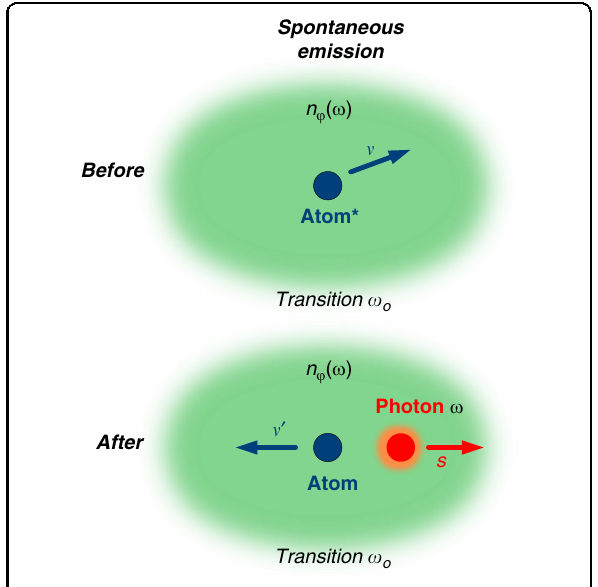
Fig. 1 Schematic of the spontaneous emission process inside NZI materials of refractive index n φ ( ω ) (green background). An atom (blue) moves around at a velocity v ( v ′ ) before (after) spontaneous emission process. A photon (red) is being emitted after the excited atom relaxed in its ground state, in direction